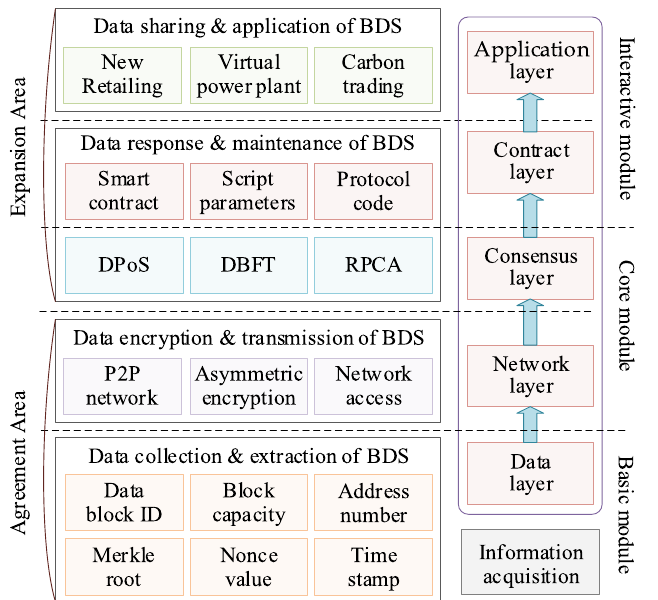
Figure 3. Framework structure of the enterprise